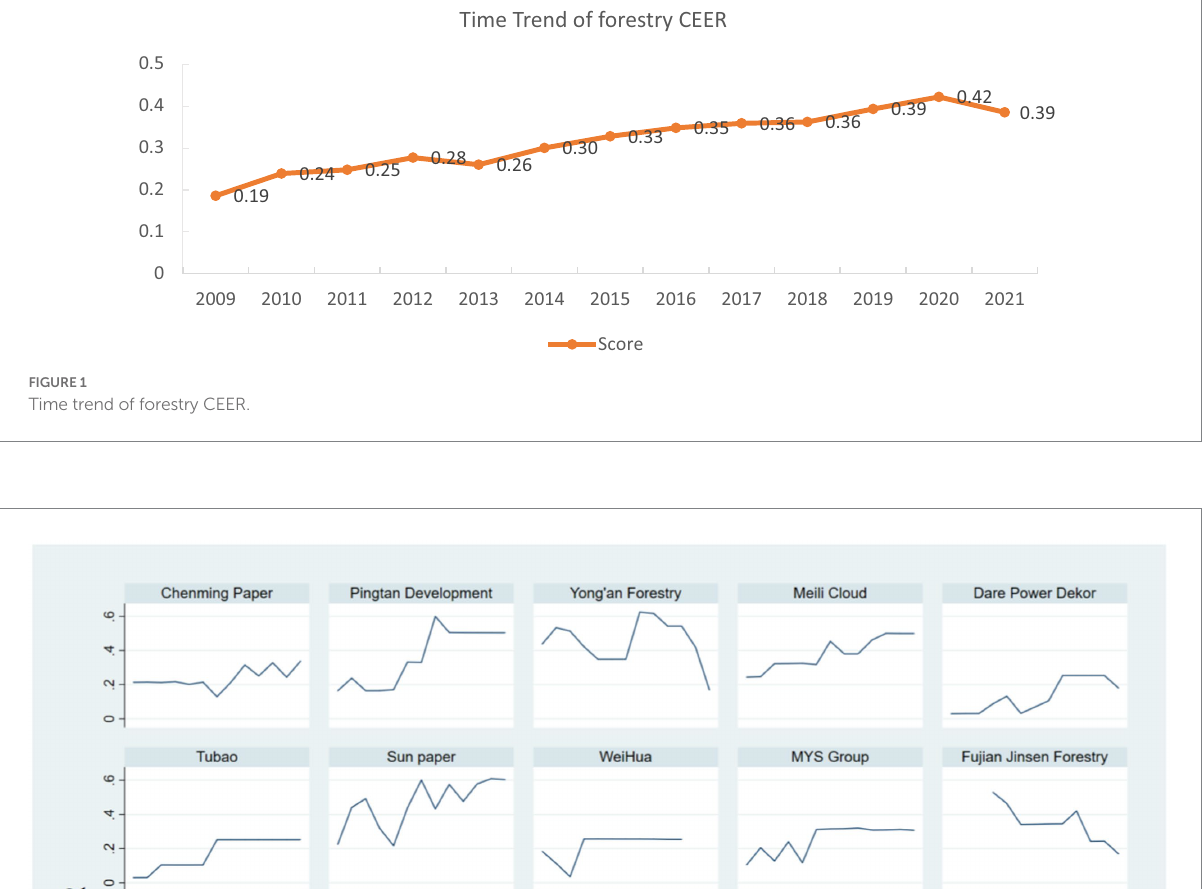
FIGURE 2 Forestry CEER time trend of each company.